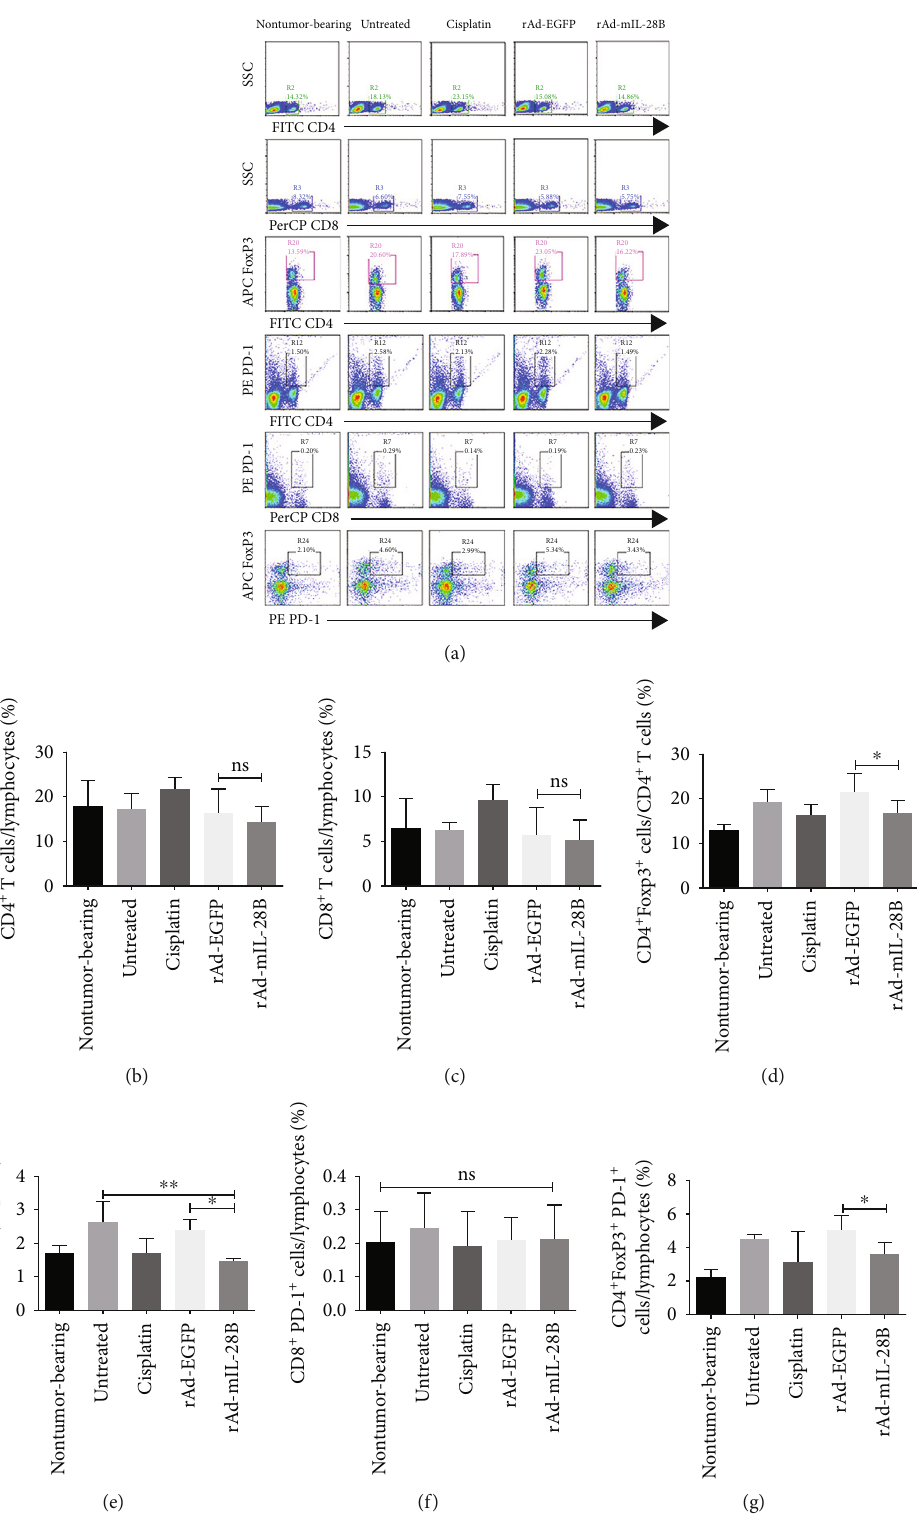
Figure 2: Intratumoral IL-28B gene transfer decreased the frequency of Tregs in the spleen. Spleens were harvested; processed into single-cell suspension; stained with FITC-conjugated anti-CD4, PerCP-conjugated anti-CD8, PE-conjugated anti-PD-1, and APC- conjugated anti-Foxp3; and analyzed by fl ow cytometry. (a) Representative dot plots and percentages of cells bounded by each region are shown in panels. (b) Statistical analysis of the percentages of CD4 + T cells, CD8 + T cells, and CD4 + Foxp3 + cells among CD4 + T cells, CD4 + PD-1 + T cells, CD8 + PD-1 + T cells, and CD4 + Foxp3 + PD-1 + T cells in the spleens were shown. Data from one experiment, each performed with three mice, are shown. ∗ P < 0 : 05 , ∗∗ P < 0 : 01 ; and ns indicated P > 0 : 05